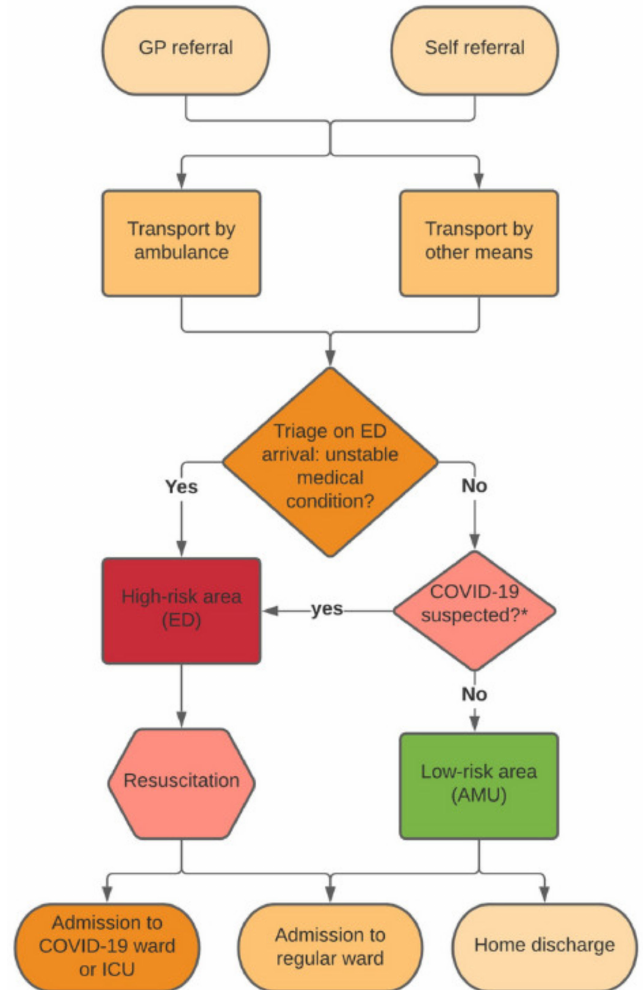
Figure 1. Flowchart of pre-triage screening COVID-19 suspected patients in the emergency depart- ment. GP, general practitioner; ED, emergency department; AMU, acute medical unit; ICU, intensive care unit. * Based on latest guidelines concerning symptoms, known COVID-19 contacts and travel history. Figure adapted from Barten et al.